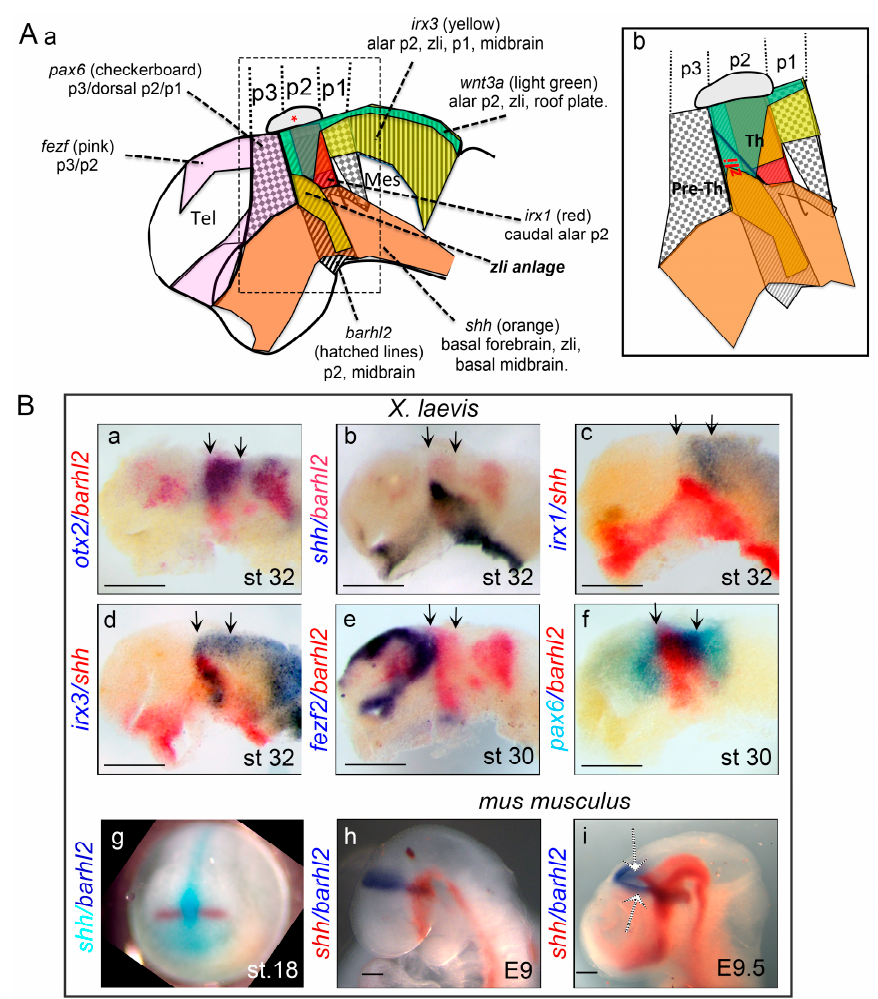
Figure 1. Schematic of Xenopus ( X. ) laevis forebrain markers and flat-mounted neural tubes from X. laevis and Mus musculus embryo after whole-mount double in situ -hybridization (WM-dISH). ( A ) Schematic of X. laevis forebrain markers at st. 30. ( a ) Areas of expression are shown and indicated for fezf2 (pink), pax6 (checkerboard pattern), irx3 (yellow), wnt3a (light green), shh (orange), barhl2 (hatched lines), and irx1 (red). ( b ) Enlargement of the diencephalic part indicated by a rectangle in ( a ). The pineal gland located on top of p2 is marked by an asterisk. The future zli is indicated in ( b ). p: prosomere; Tel: telencephalon; Mes: mesencephalon; Pre-Th: pre-thalamus; zli: zona limitans intrathalamica ; Th: thalamus. ( B ) WM-dISH is performed using otx2 , irx1 , irx3 , fezf2 , pax6, and shh or barhl2 as probes on ( a – g ). X. laevis and mouse embryos at different developmental stages as indicated. Neural tubes ( a – f ) or heads ( h , i ) of representative embryos, dissected and flat-mounted, are shown from a side view, dorsal up, anterior left except for ( g ), shown in anterior view, dorsal side up. The markers and stages are indicated. Black arrows indicate the rostral and caudal boundaries of p2. White arrows indicate the bilateral zli . Scale bar: 0.5 mm.